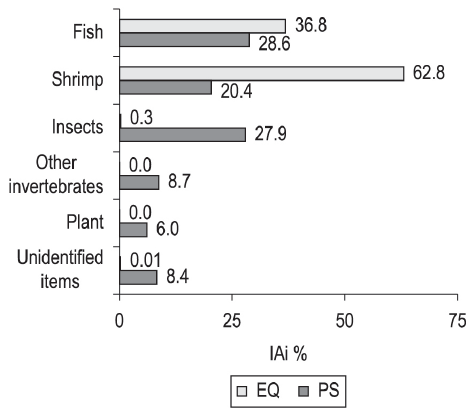
Figure 5. Feed items consumed (IAi%) by predator fish species from the Paulo Sarasate (PS) and Edson Queiroz (EQ)